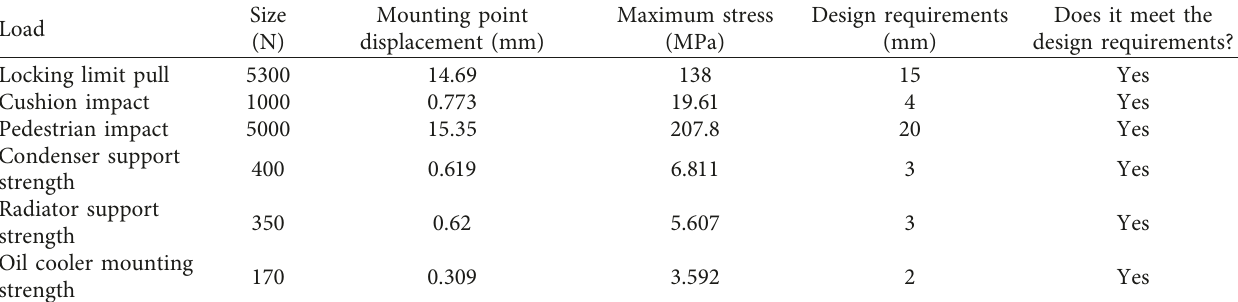
Table 5: Static analysis information